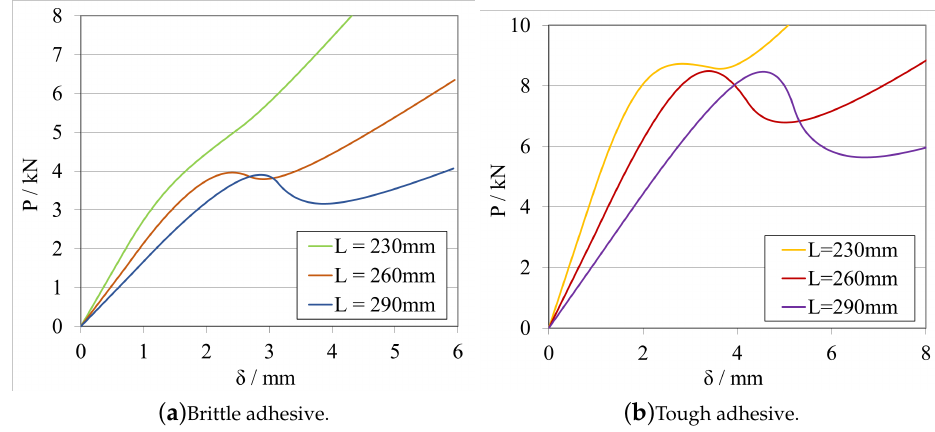
Figure 10. P - δ curves related to the L ELS study.